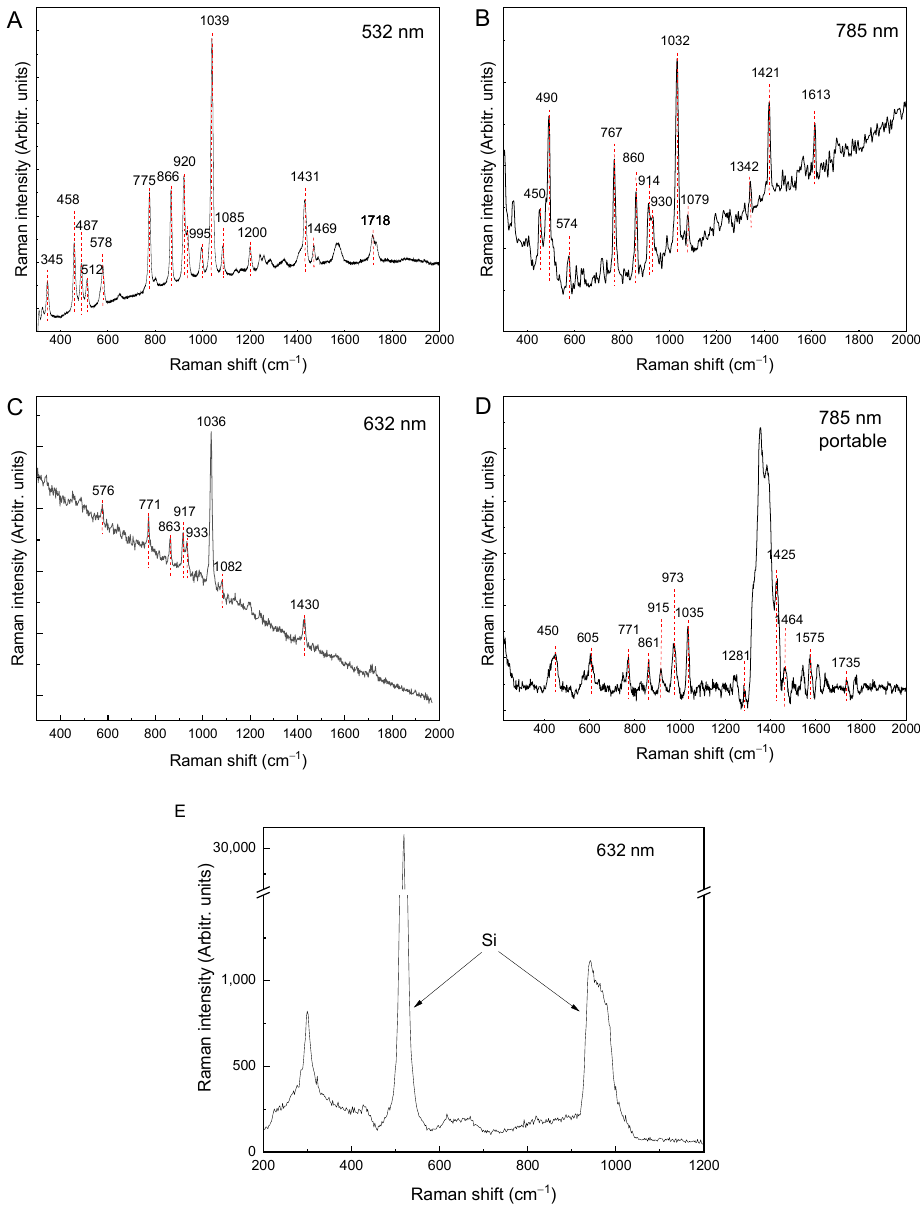
Figure 2. Raman spectra of glyphosate powder recorded with different laser excitations: ( A ) 532 nm ( B ) 785 nm, ( C ) 632 nm, ( D ) 785 nm (portable Raman; baseline corrected), and ( E ) Raman spectrum of 10 mM glyphosate solution excited at 632 nm on Si wafer.